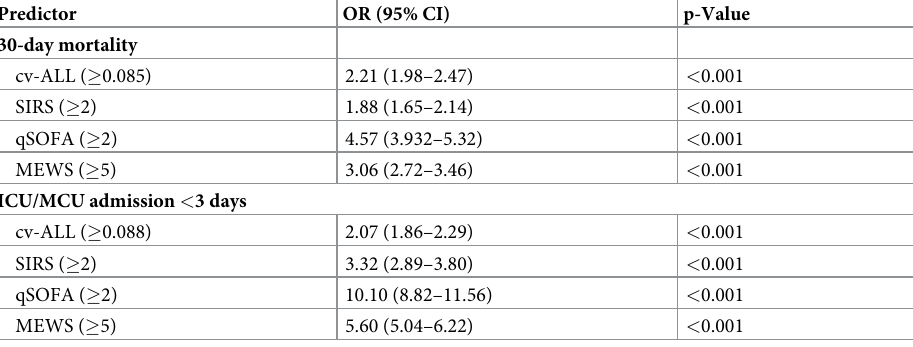
Table 2. Univariate logistic regression for 30-day